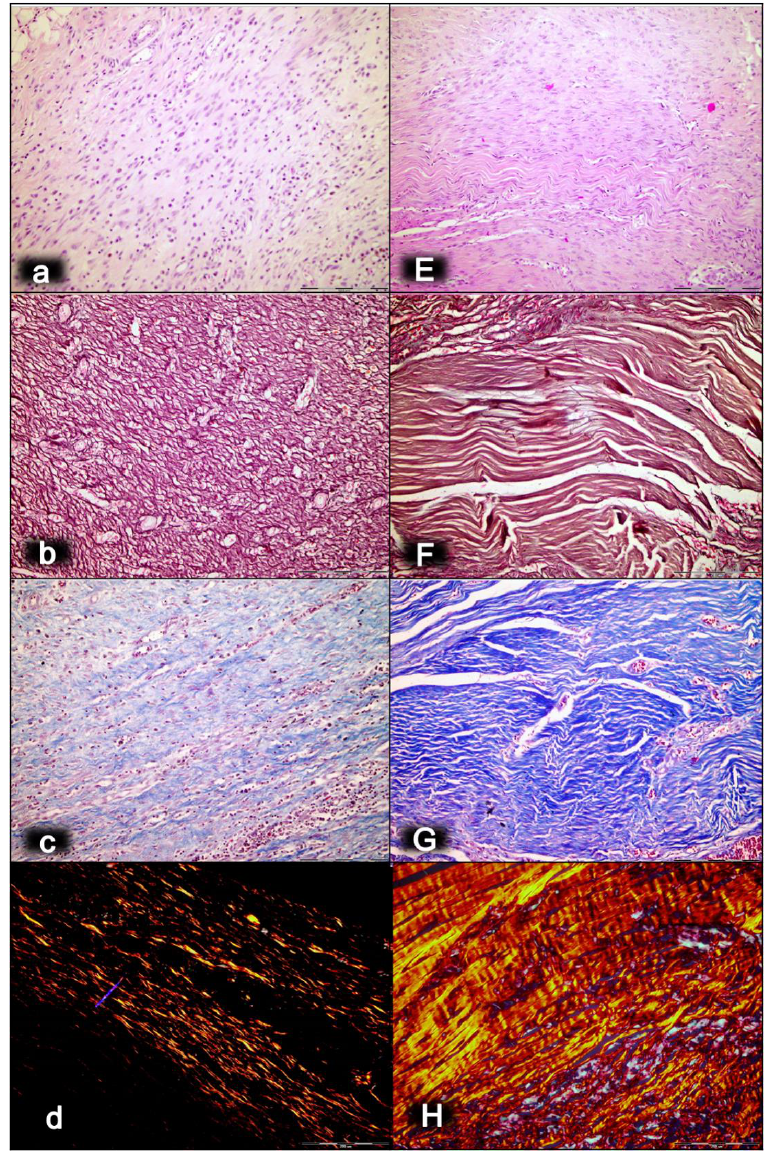
Figure 3. Myotendinous junction 28 days following dissection of quadriceps tendon from the quadriceps muscle [43]. Regular presentation after myotendinous junction injury induction in control rats (small letters) ( a – d ). No edema and inflammatory cells were found with vanishing myotendinous junction revascularization ( a ). The proliferation of fibroblasts and fibers, both reticulin ( b ) and collagen fibers ( c ), as well as fiber maturation (much less than in BPC 157 treated rats) with suboptimal orientation to the long axes of the myofibers close to the myotendinous junction. Regular presentation after myotendinous junction injury during BPC 157 regimen (capitals), given in drinking water ( E – H ). Well-oriented dense connective tissue was found ( E ). Morphologic features of the myotendinous junction area indicate that BPC 157 therapy favors vascular density as well as reconstruction and orientation of reticulin ( F ) and collagen fibers ( G ). A prominent proliferation of fibroblasts and fibers as well as fiber maturation was obtained (confirmed with polarized microscope; H ), providing tenable fibroblast and fiber proliferation with optimal orientation due to the long axes of the myofibers close to the myotendinous junction with a lesser number of fibroblasts, and with a higher amount of reticulin and collagen fibers. In contrast, the control group showed far less abundant and well- oriented collagen type 1 fibers ( d ). HE staining ( a , E ); histochemical Gomori staining ( b , F ) and Masson trichrome staining ( c , G ); Sirius red histochemical staining with polarized microscopy ( d , H ); magnification ×